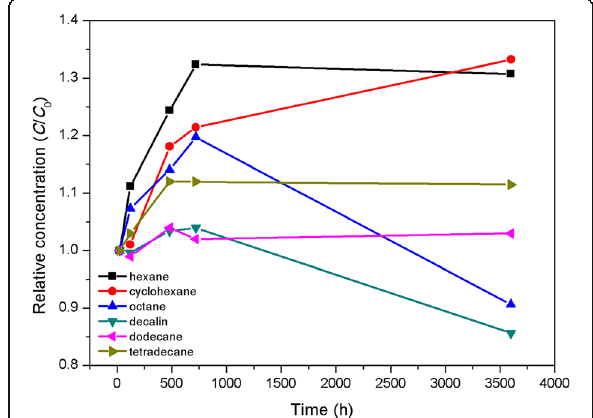
Fig. 9 Relative supernatant particle concentration of Au@DSHPG-2 in different